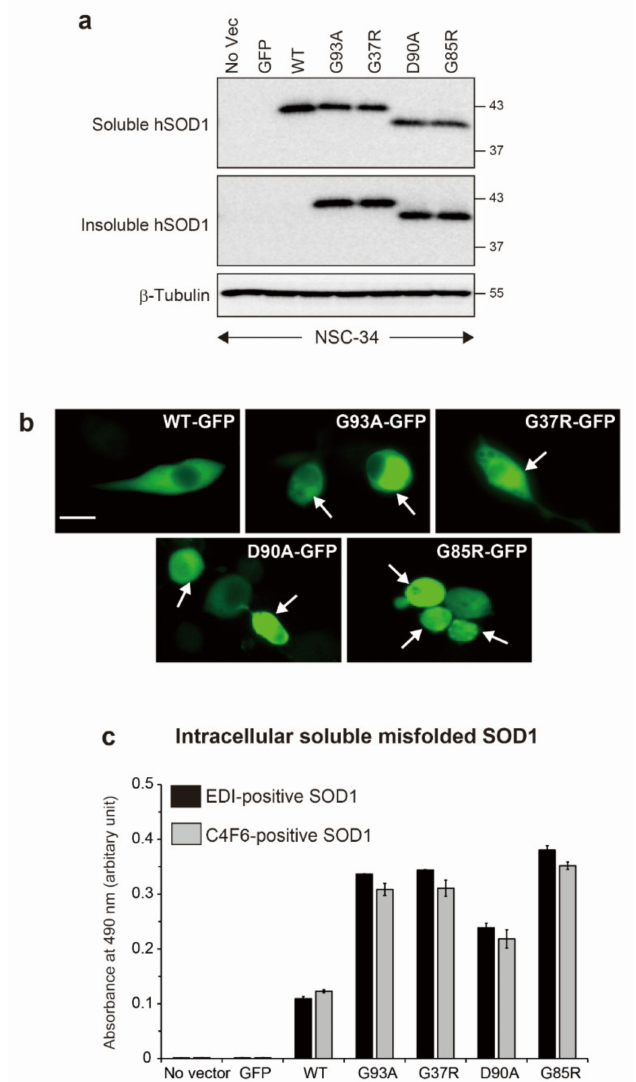
Figure 1. Generation of motor neuron models of ALS in which misfolded and aggregated hSOD1 are intracellularly deposited. NSC-34 cells were transiently transfected with expression vectors encoding human wild-type superoxide dismutase 1 (hSOD1 WT ) or the ALS-causing hSOD1 mutants (G93A, G37R, D90A, and G85R) tagged with green fluorescent protein (GFP), treated with all trans -retinoic acid, and cultured for 72 h. ( a ) Western blots of hSOD1 in the Nonidet P-40 (NP-40) soluble and insoluble factions from NSC-34 cells, β -tubulin was used as a loading control. No Vec., untransfected cells; ( b ) florescence microscopy of cells transfected with hSOD1 WT GFP or the ALS-linked hSOD1 mutant GFP. Arrows indicate protein aggregations containing hSOD1 GFP. Scale bar = 10 µ m; ( c ) enzyme-linked immunosorbent assay signals of (black) EDI-positive and (gray) C4F6-positive misfolded SOD1 in the NP-40 soluble fraction. All data are shown as the mean ± SD, n = 3 in each